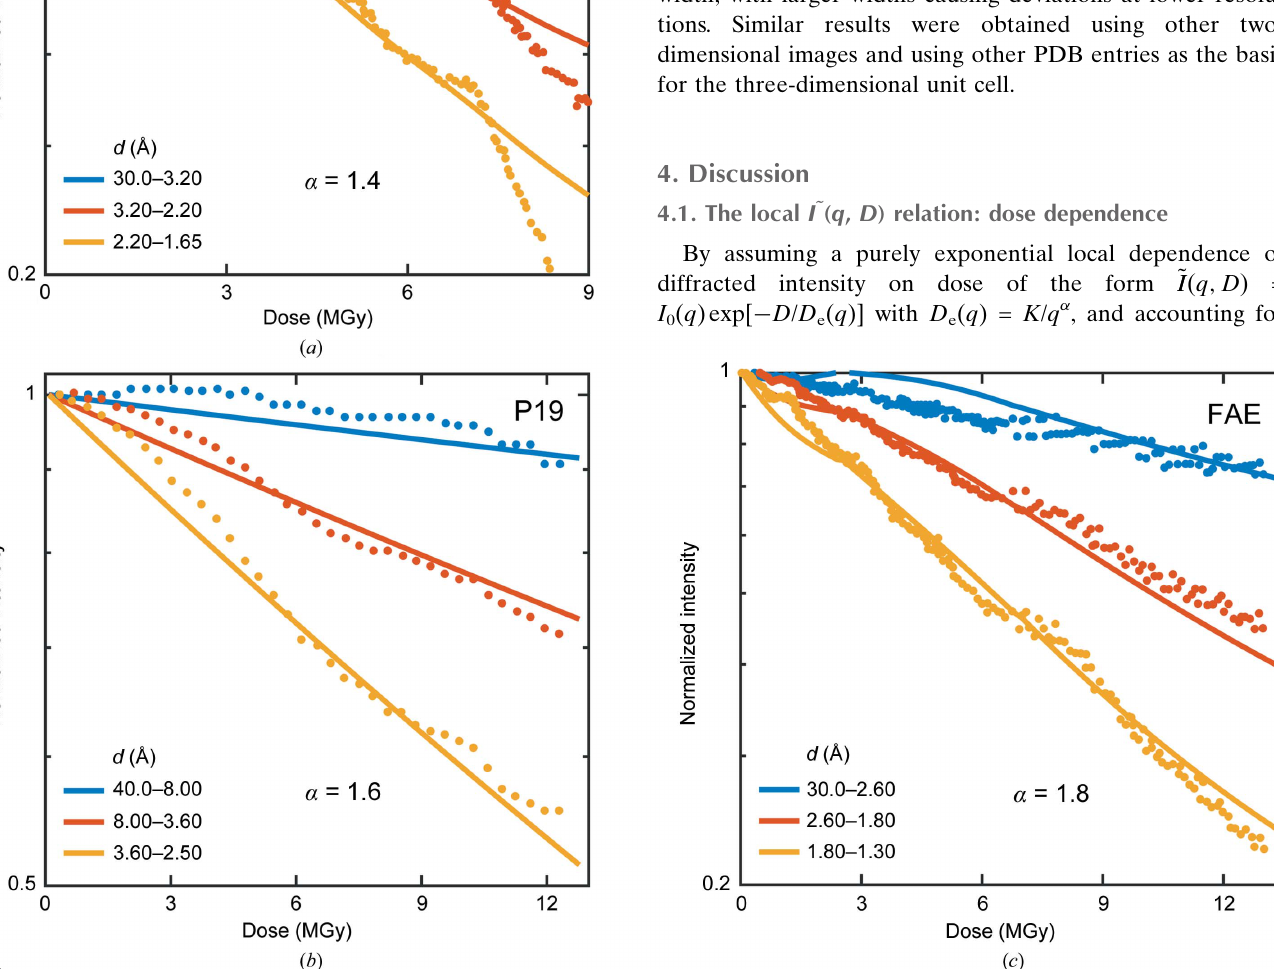
Figure 4 Experimental data (solid circles) for integrated intensity in resolution shells versus dose for crystals of insulin, P19 and FAE at 100 K, as measured by Bourenkov & Popov (2010) (Figs. 3, 4 and 6 in the original paper). Crystals were rotated continuously during irradiation as for crystallographic data collection. Oscillations in the data may be owing to irregular crystal shapes and large rotations that produce complex dose distributions within the X-ray- illuminated volume. The solid lines indicate the results from simulations with best-fit exponents (cid:2) of ( a ) 1.4, ( b ) 1.6 and ( c )